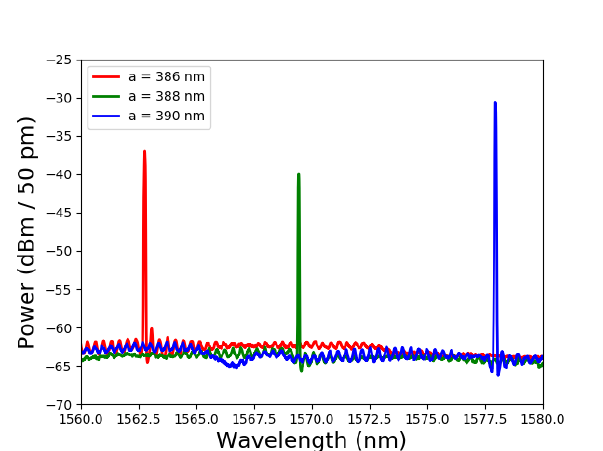
Figure 7. Measured optical spectra of external cavity lasers with PhC cavity lattice spacings of 386nm,388nm, and 390nm. The lasers are operating at wavelengths of 1562.76nm,1569.42nm, and 1577.95nm with SMSR of 26dB,24dB, and 33dB respectively.